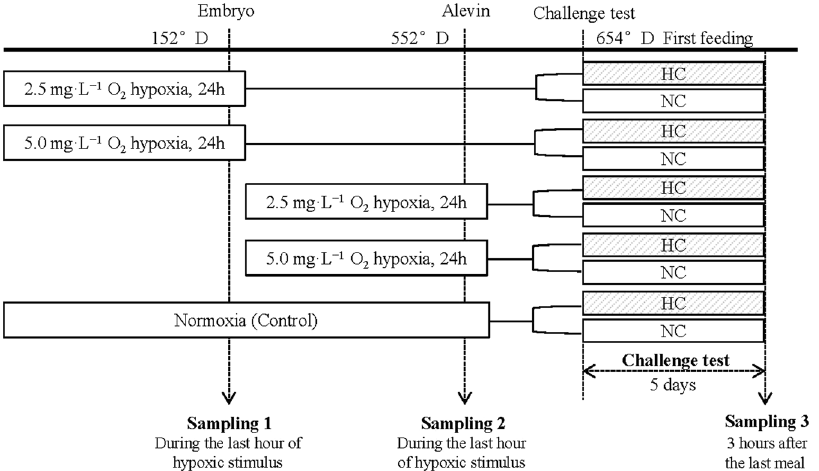
Figure 3. Experimental design. Two levels of hypoxic stimulus (2.5 or 5.0 mg·L − 1 O 2 ) were applied to rainbow trout for 24 h at the embryo (152 °D) or alevin stages (552 °D). The fish were then fed either a high carbohydrate (HC) or a no carbohydrate (NC) diet at first-feeding. The normoxic group serves as the